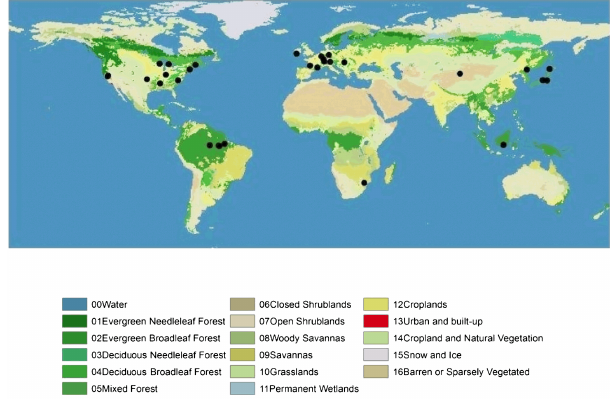
Figure 1. The distribution of the 30 eddy covariance tower sites used for evaluating R N and (cid:56) .